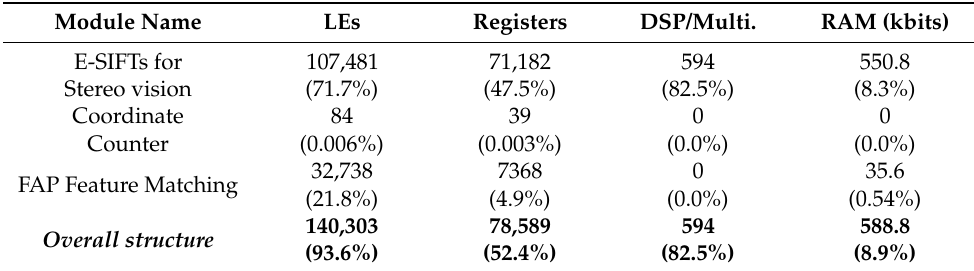
Table 5. Hardware resources utilized in the proposed Figure 28. Usage ratio of ( a ) LE used and ( b ) registers used for the proposed E-SIFTs and FAP feature matching.